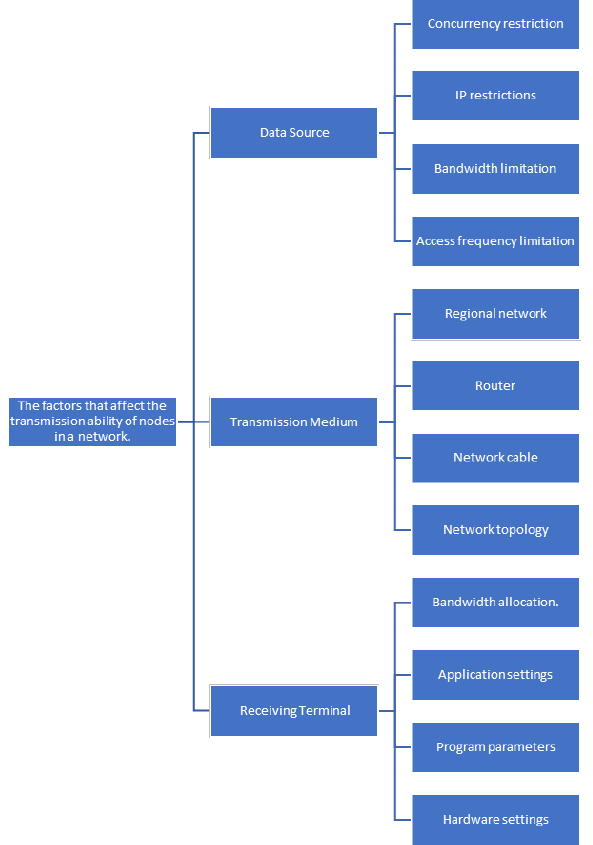
Figure 1 . The factors that affect the transmission ability